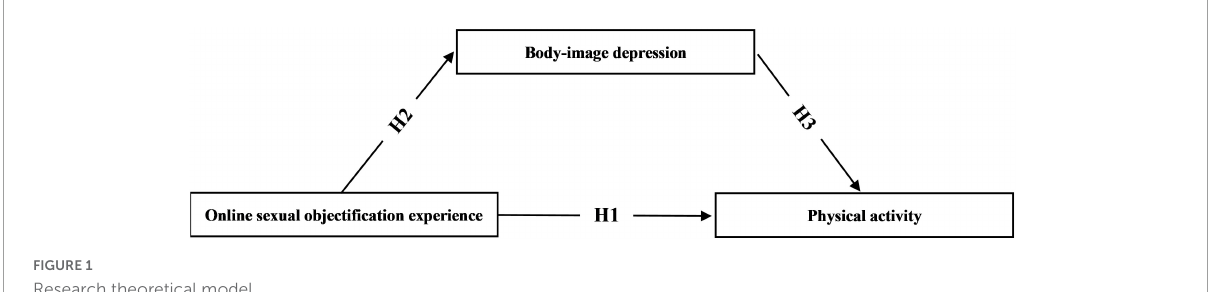
FIGURE1 Research theoretical